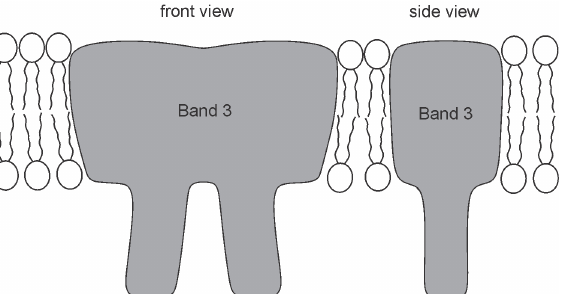
Figure 10. Nematic-type orientational ordering within the membranes of red blood cells or extra- cellular vesicles could arise due to anisotropic proteins such as Band 3 proteins embedded within membrane. See also Figure 6. Adapted with permission from ref. [137]. 2019 Springer Nature.